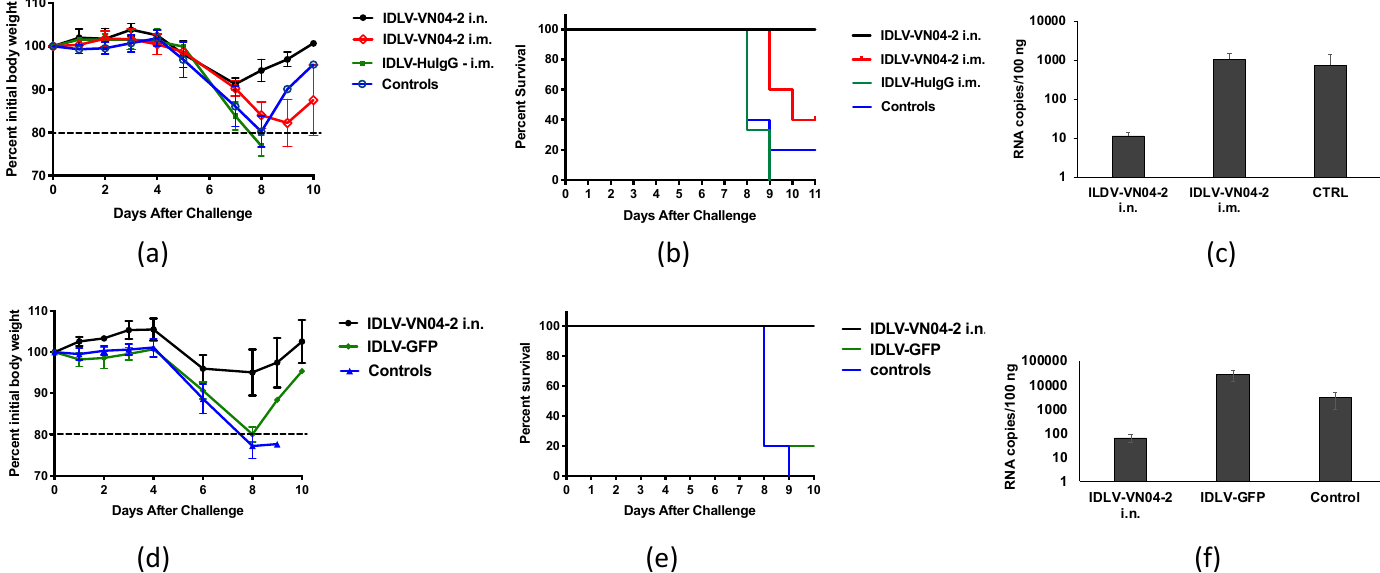
Figure 5. Administration of IDLV-VN04-2 protects from H5 IAV challenge BALB/c mice ( n = 5) received IDLV-VN04-2 either by the i.n. or i.m. route (250 or 500 ng RT units, respectively), and IDLV-huG1 by the i.m. route or were left unimmunized as a control ( a , b,c ). In a separate experiment, mice received 250 ng RT units of either IDLV-VN04-2 or IDLV-GFP by the i.n. route or were left unimmunized as a control ( d , e,f ). Mice were lethally challenged with 2 LD50 of VNH5N1-PR8 IAV 3 days after IDLV administration and monitored for weight loss ( a , d ) and survival ( b , e ). Mice that lost ≥ 20% of their initial body weight were euthanized and counted as dead. Comparison of survival curve ( b ) p = 0.0096 and ( c ) p = 0.0004 Log-rank Mantel–Cox test. Protection experiments are representative of three independent replicates. Influenza copy numbers in the lungs were measured by real-time PCR and are shown in ( c ) and ( f ).